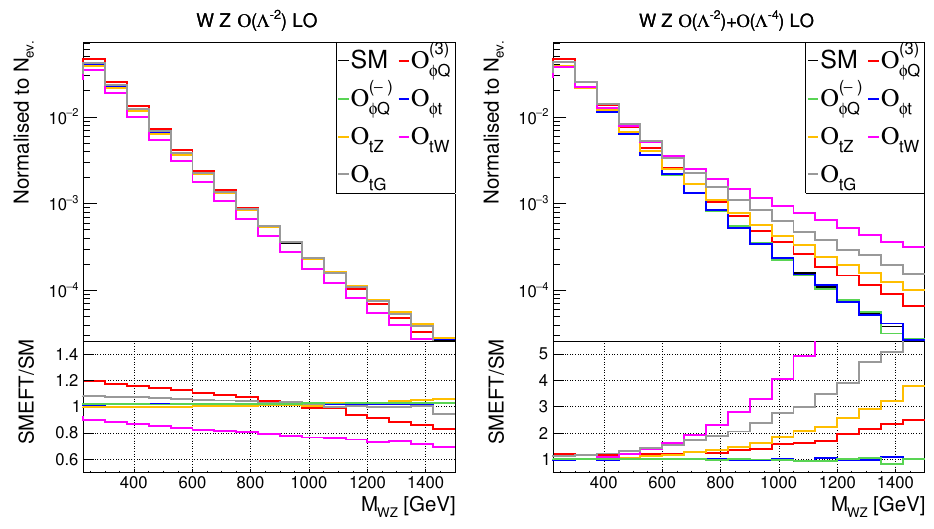
Figure 7 . Same as figures 6 ( left ) and 14 ( right ), but showing contributions to the total, unpolarised